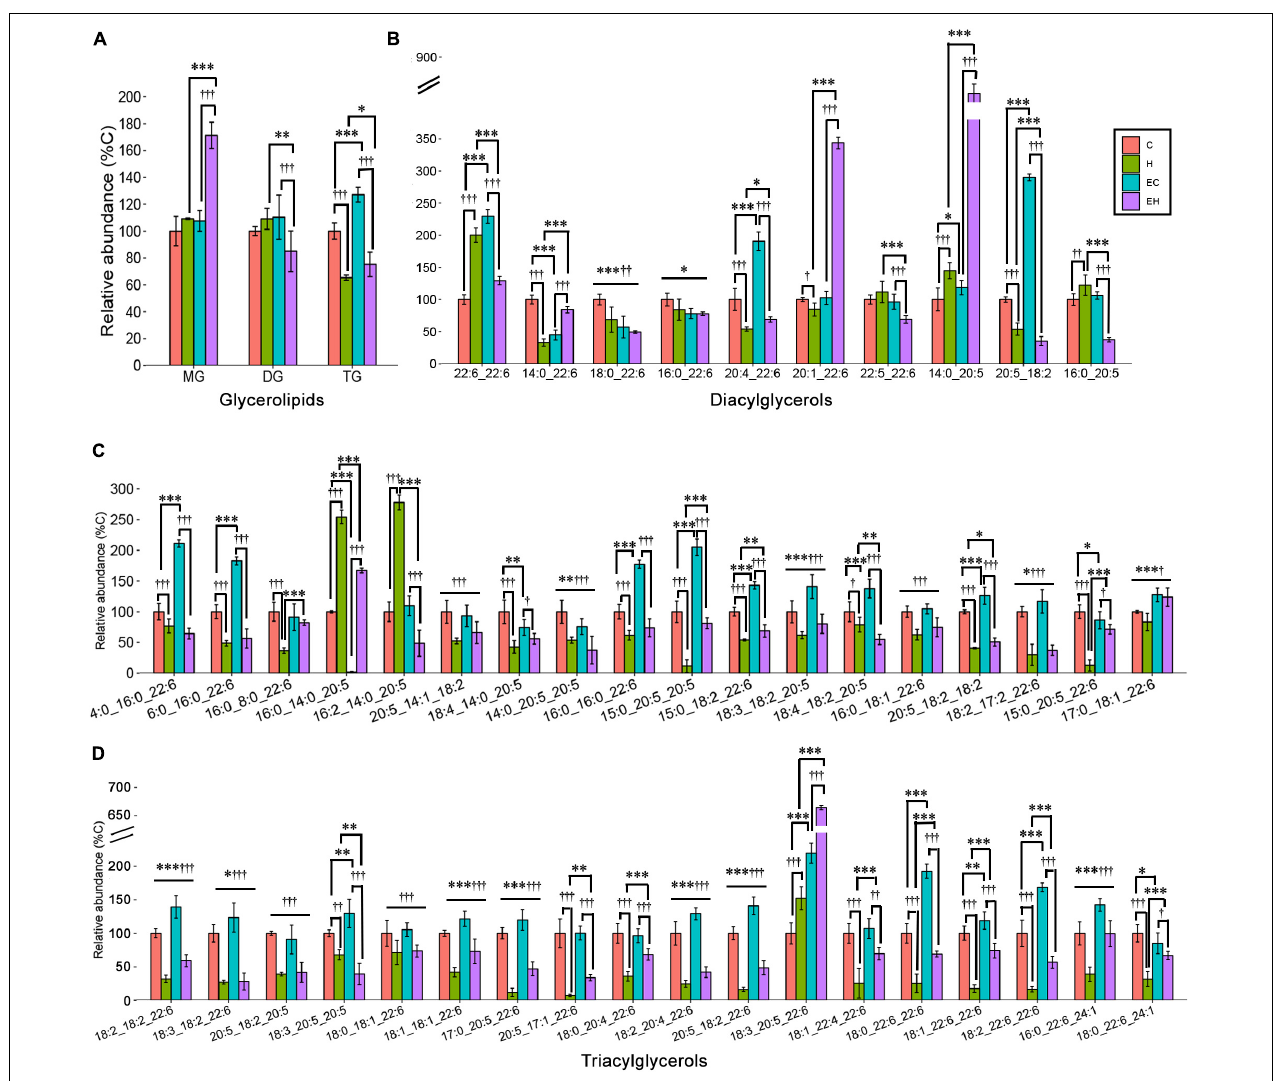
FIGURE 5 | Effects of endurance training and/or high-fat diet on ω -3 PUFA-containing GL (A) , ω -3 PUFA-containing DG species (B) and ω -3 PUFA-containing TG species with statistical significance (C,D) in skeletal muscle: ∗ p < 0.05 for endurance training effect; ∗∗ p < 0.01 for endurance training effect; ∗∗∗ p < 0.001 for endurance training effect; † p < 0.05 for high-fat diet effect; †† p < 0.01 for high-fat diet effect; ††† p < 0.001 for high-fat diet effect; straight lines represent the main effect of endurance training or high-fat diet; lines with sticks represent an interaction effect exists between endurance training and high-fat diet. Data are means ±